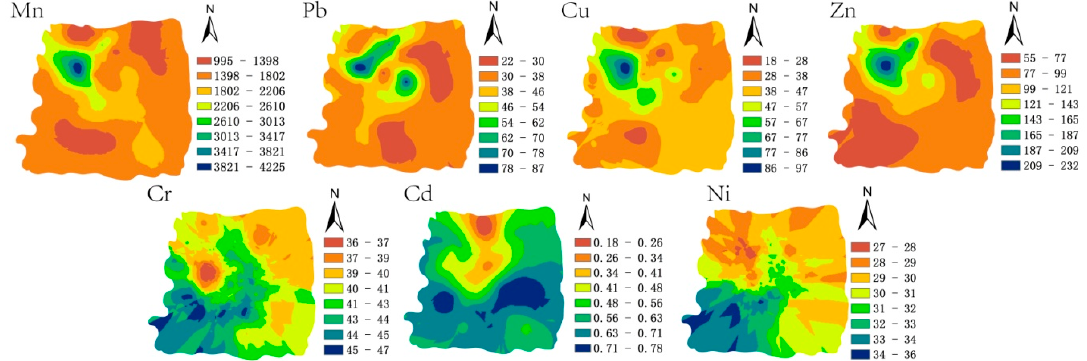
Figure 2. PTE concentration (mg/kg) distribution in the soil of the study area.